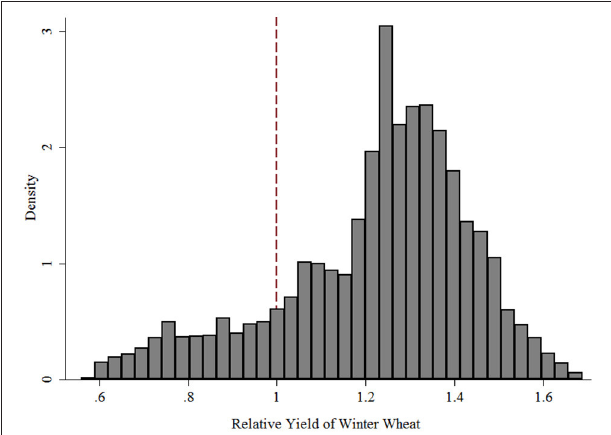
FIGURE 3 | Distribution of simulated relative yields of winter wheat for large farms in the REACCH study area using the annual cropping system in 2050, based on downscaled CMIP5 data from one global climate model and RCP4.5. Relative yield is defined as the yield simulated with future climate divided by the yield simulated with current climate at the same site for the same crop